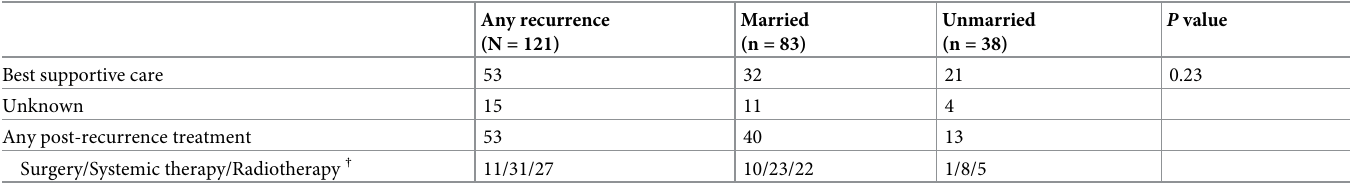
Table 2. The status of post-recurrence treatment in the married and unmarried patients for the entire cohort.